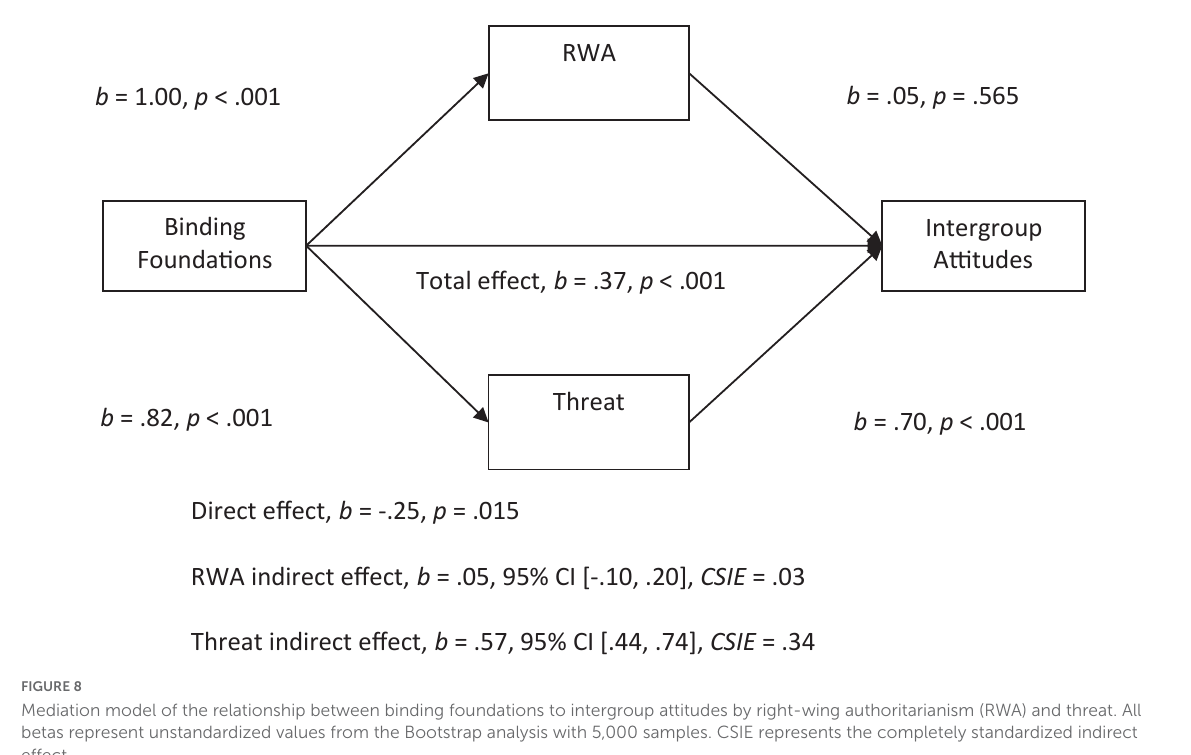
FIGURE8 Mediation model of the relationship between binding foundations to intergroup attitudes by right-wing authoritarianism (RWA) and threat. All betas represent unstandardized values from the Bootstrap analysis with 5,000 samples. CSIE represents the completely standardized indirect